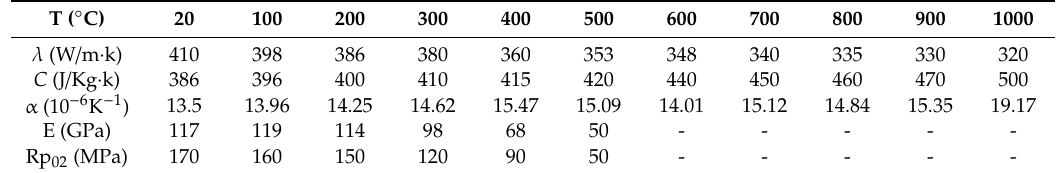
Table 4. Physical properties of copper [6].